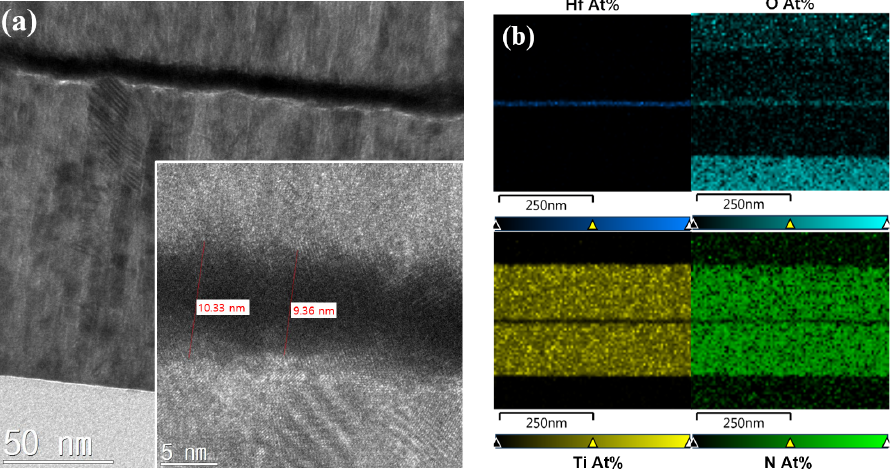
Figure 2. ( a ) Cross-sectional TEM images. ( b ) EDS analysis of the fabricated HfO 2 -based MFM ca- pacitor.